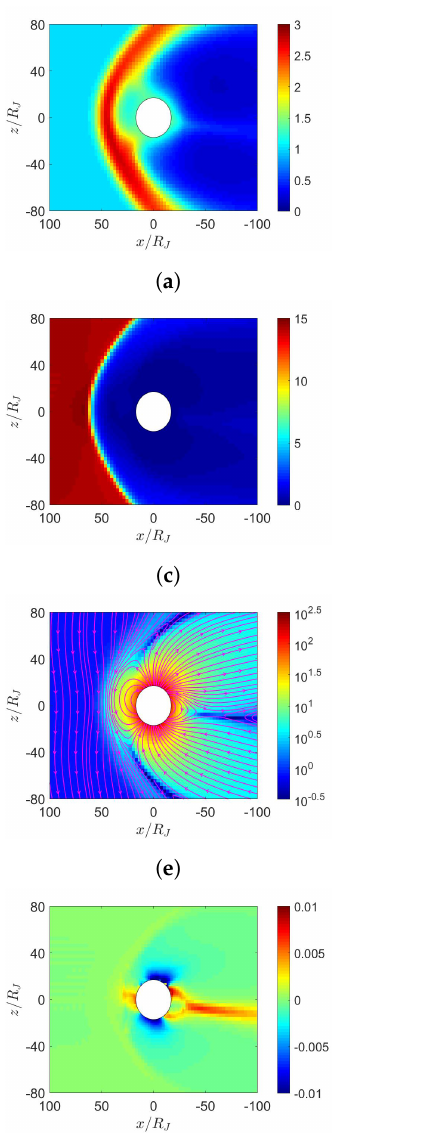
Figure 13. Distributions around Jupiter of ( a ) n (cm − 3 ), ( b ) ¯ u xz (km/s), ( c ) magnetosonic Mach number, ( d ) P (nPa), ( e ) ¯ B xz (nT), ( f ) J y (nA/m 2 ), ( g ) J r (nA/m 2 ); maximum dipole tilt points away from sun at t = 0, under northward IMF, t = 21.19 h.